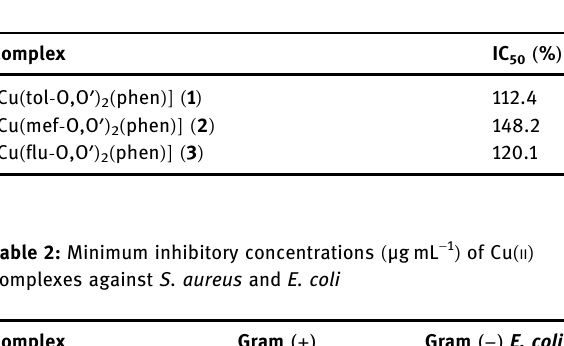
Table 1: Inhibitory concentrations of complexes 1 – 3 required to cause a 50% decrease in the growth of E. coli bacterial culture ( IC 50 ) at 24 h